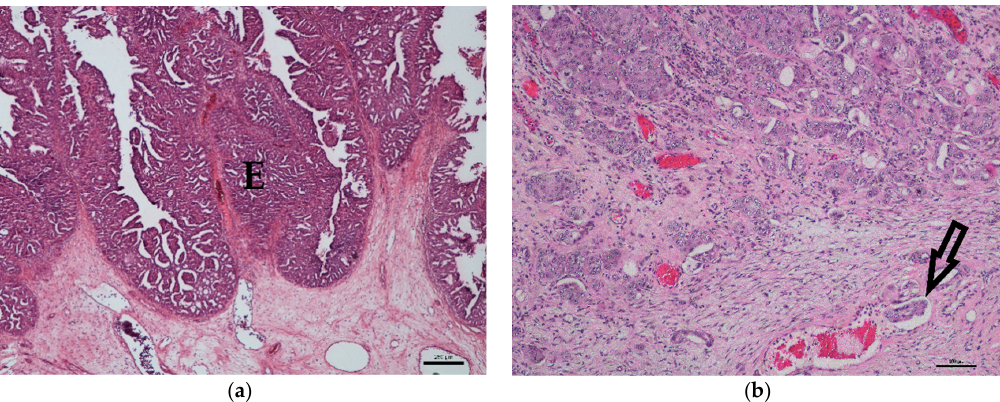
Figure 1. Histology of canine transitional cell carcinoma specimens. ( a ) Low-grade transitional cell carcinoma of an 11-year-old male mongrel. The epithelium (E) is markedly thickened and multi-layered, and the irregularly-arranged cells show mild anisocytosis and anisokaryosis. The basement membrane is intact (HE, bar = 250 μ m). ( b ) High-grade transitional cell carcinoma of an eight-year-old castrated male mongrel with marked anisocytosis and anisokaryosis. The tumor intensively invades the submucosa, and additionally, an intravascular tumor cell embolus (arrow) is detectable (HE, bar = 100 μ m). Dogs with high-grade TCC (Figure 1b) were also, on average, 11 years old (range: 6–13 years). The growth pattern was non-papillary in 25 cases and papillary in 20 cases. The neoplasms massively invaded either the submucosa (6/45) or submucosa and muscularis (39/45). Anisocytosis and anisokaryosis were moderate to marked, and several mitoses/HPF were counted. Vascular attachment (35/45) and vascular invasion (23/45) were identified in many cases.